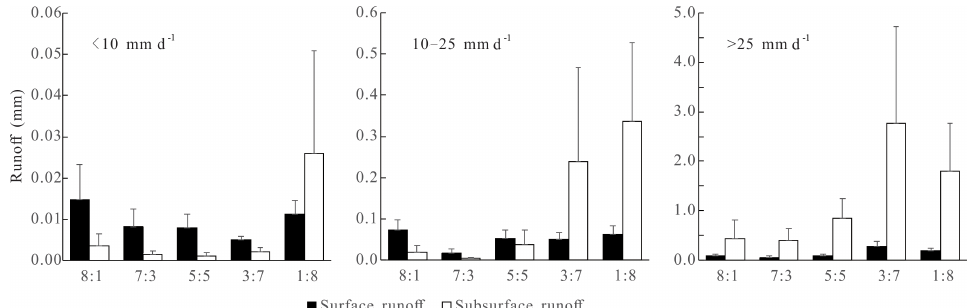
Figure 2. Average runoff generated in LGM slopes under natural precipitation. Table 4. Hydro-physical properties of LGM ( R L = 2 : 8) with different compaction degrees. Compacted plot Moisture content (%) RP (%) Theoretical Annual Maximum Minimum porosity mean monthly mean monthly mean CL1